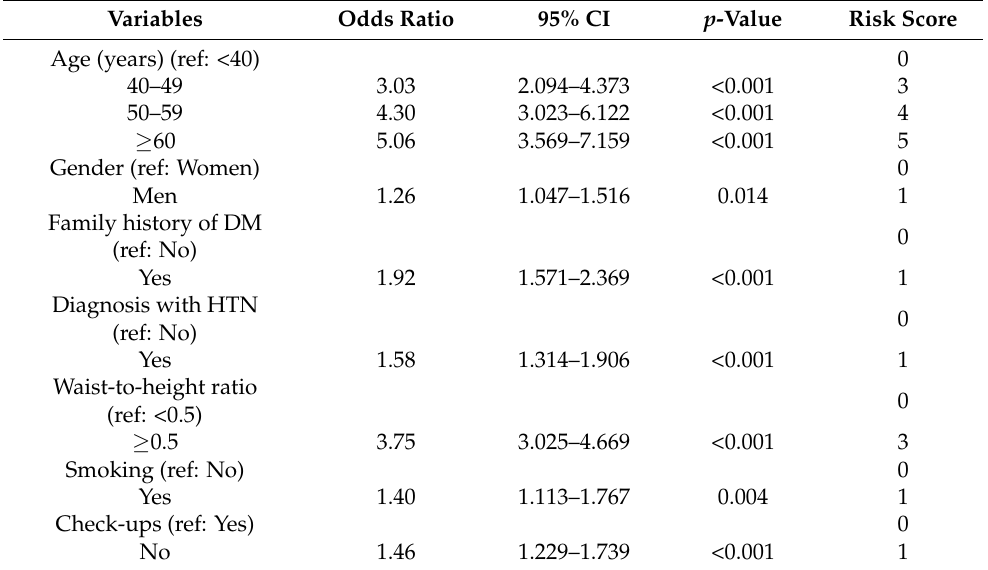
Table 2. Factors affecting HbA1c levels and imputation of scores according to odds